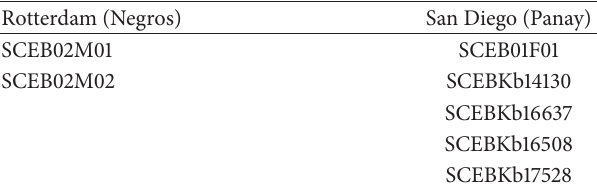
Table 1: Sample codes of resequencing data available for seven Sus cebifrons individuals, two from Rotterdam zoo and five from San Diego